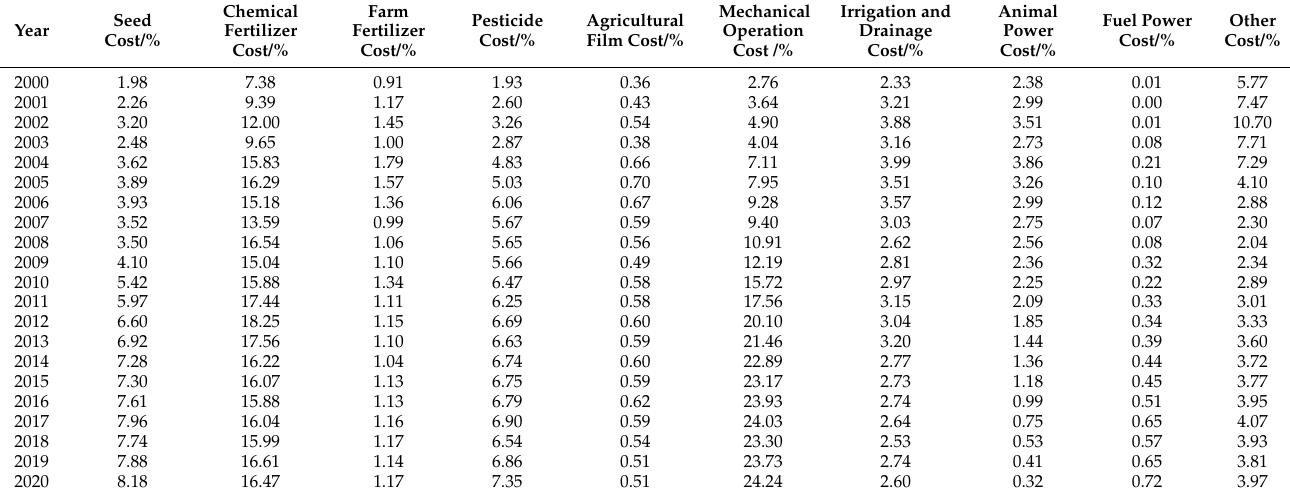
Table A3. Capital contribution rate and its decomposition from 2000 to